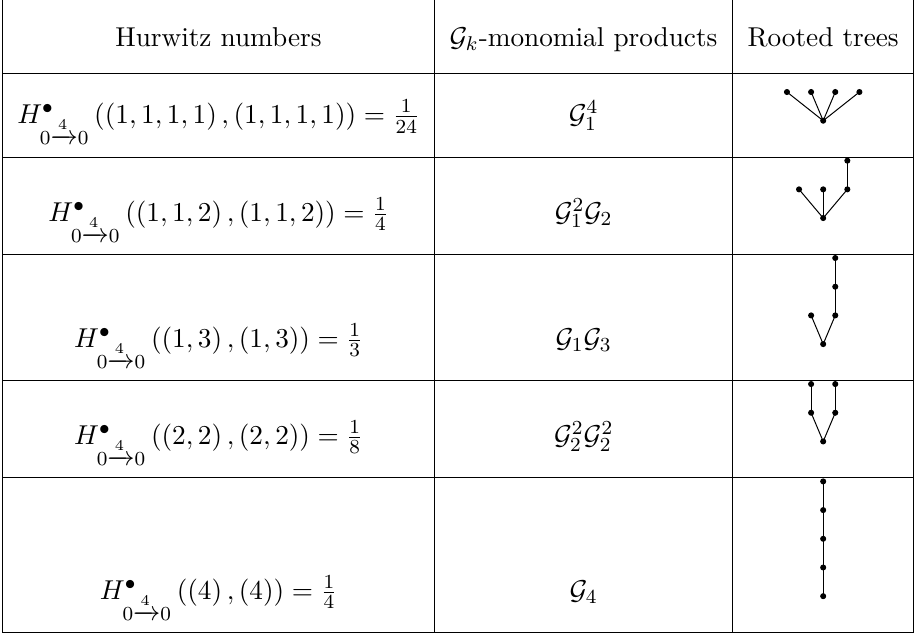
Table 1 . n = 4 Hurwitz numbers, associated G k -monomial products and rooted